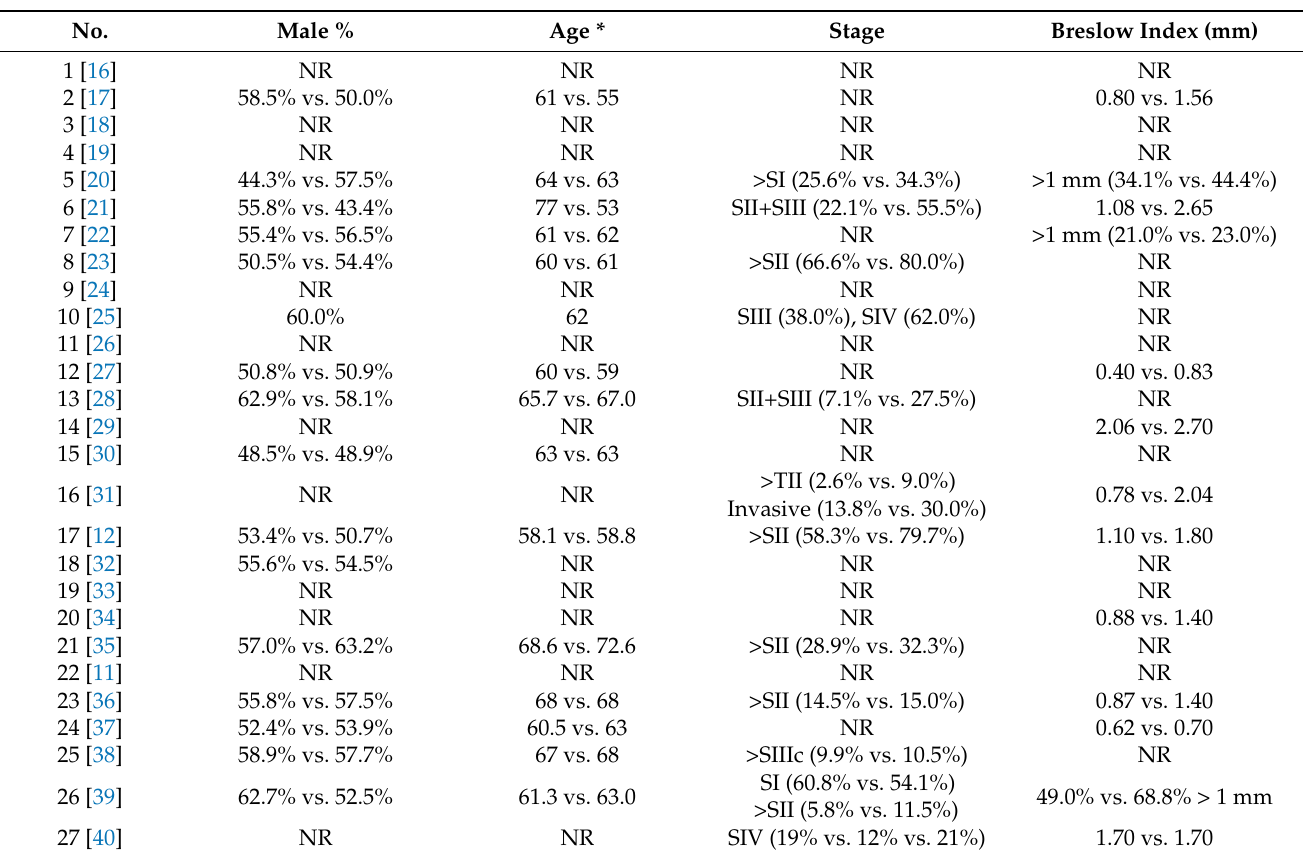
Table 2. Demographic data extracted from the studies comparing the pre-pandemic with the pan- demic